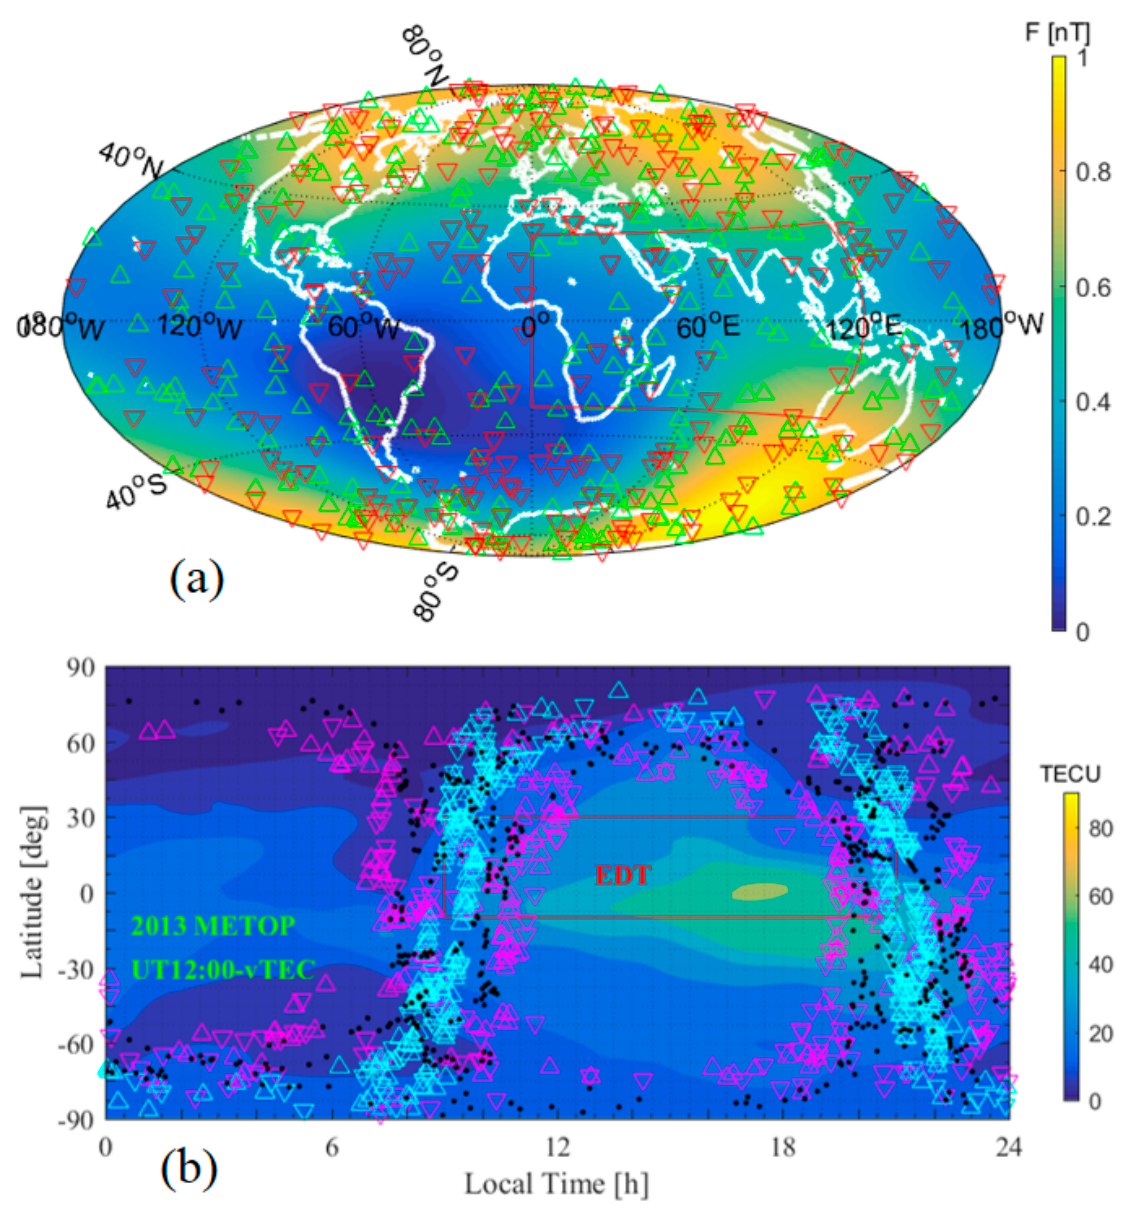
Figure 4. Panel ( a ) shows the global distribution of mean tangent point locations of 493 European Meteorological Operational satellites mission (MetOp-B) RO events on 15 July 2013, including 255 RO events with negative geomagnetic (BNe) term (red downward-pointing triangles) and 238 RO events with positive BNe term (green upward-pointing triangles), the region highlighted with a red box includes 35 positive-BNe RO events but only 17 negative-BNe RO events. The background color map illustrates the mean geomagnetic field intensity for 15 July 2013. Panel ( b ) shows the local time ( x -axis) vs. latitude ( y -axis) distribution of the mean tangent points (black dots), inbound ion.mean-altitude points (magenta triangles), and outbound ion.mean-altitude points (cyan triangles) of 493 MetOp-B RO events on 15 July 2013. Similar to panel ( a ), the upward-pointing triangles denote positive BNe while downward-pointing triangles denote negative BNe. The background color map illustrates the IGS vTEC maps at 12:00 UT on 15 July 2013, and the equatorial day time (EDT) zone is highlighted with a red